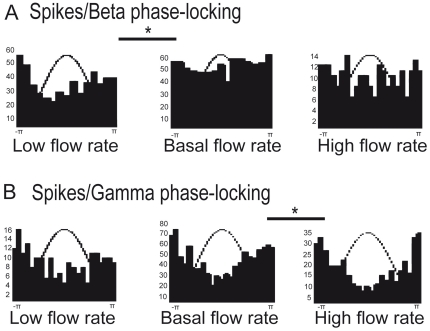
Spike phase locking to LFP oscillations is modified by nasal flow rate.Each histogram represents spike distributions relative to the oscillation phase for each flow rate condition. A) Phase locking between spikes and beta oscillations [number of spikes for each condition: low flow rate (n = 516), basal flow rate (n = 661) and high flow rate (n = 228)]. B) Phase locking between spikes and gamma oscillations [number of spikes for each condition: low flow rate (n = 188), basal flow rate (n = 1019) and high flow rate (n = 370)]. Statistical test: Equal Kappa test, *p<0.05.